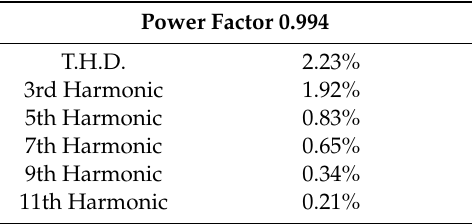
Figure 13. Measured waveforms of the load current i L , the inverter output current i o , utility-line current i s and utility-line voltage vs. during grid-connection operation. Table 4. Measured power factor, T.H.D. and odd-order harmonics of the output current during grid-connection